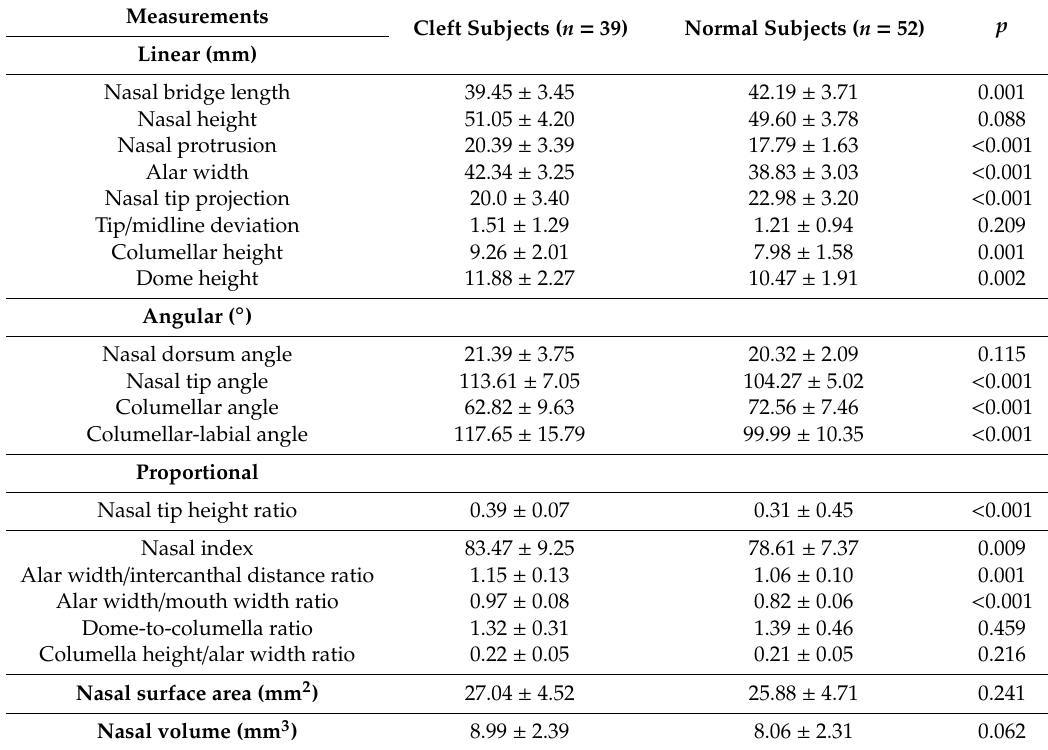
Table 4. Intergroup comparative analysis between patients with bilateral cleft lip and palate and normal